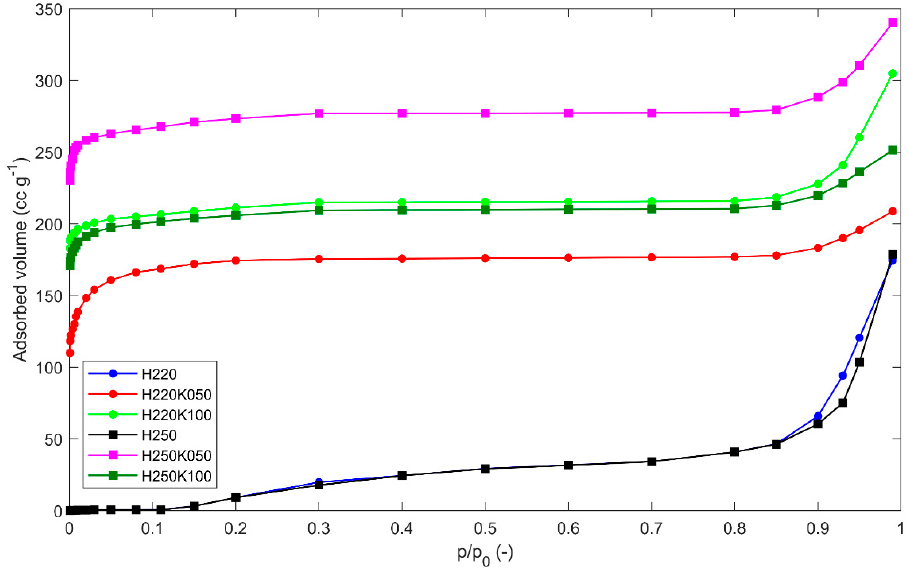
Figure 1. Nitrogen adsorption isotherms at 77 K of selected samples.